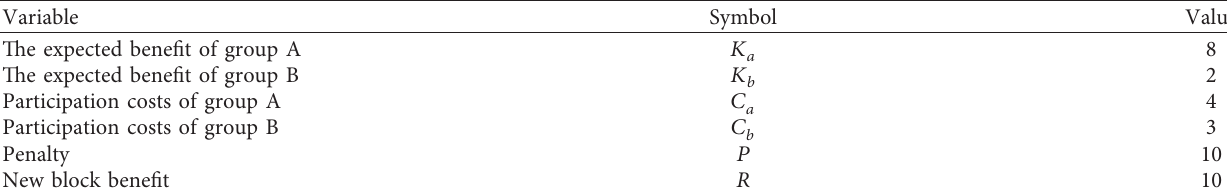
Table 2: Simulation variables and